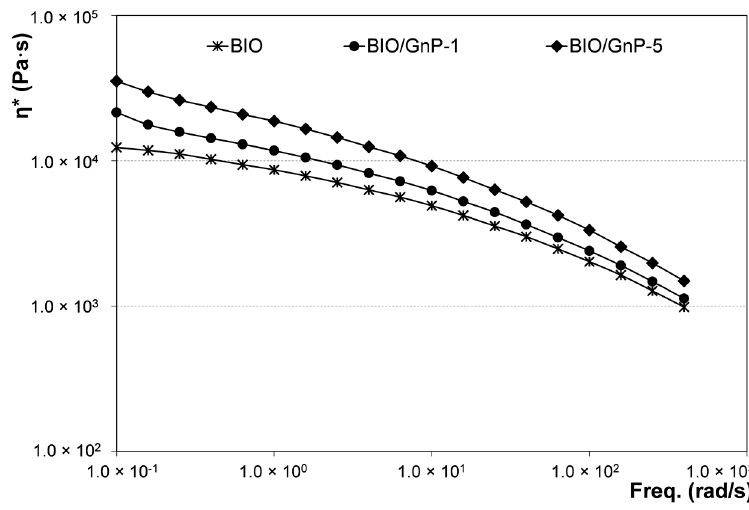
Figure 2. Complex viscosity as a function of frequency of neat BIO and related nanocomposites.